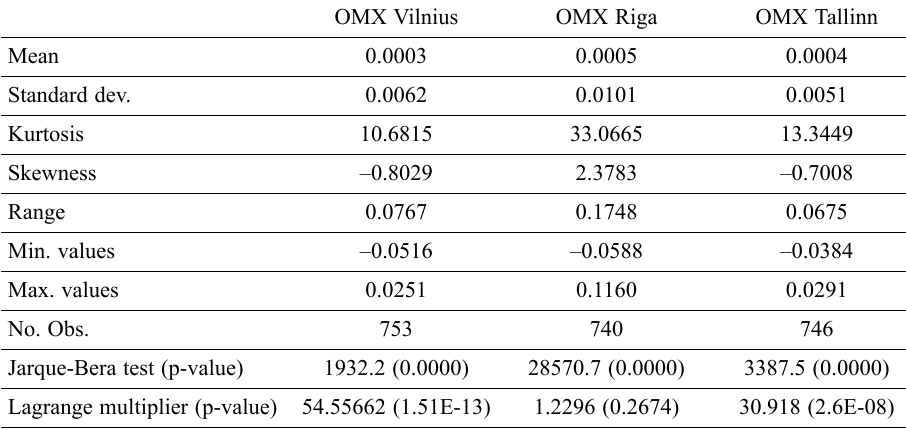
Table 1. Descriptive statistics of selected